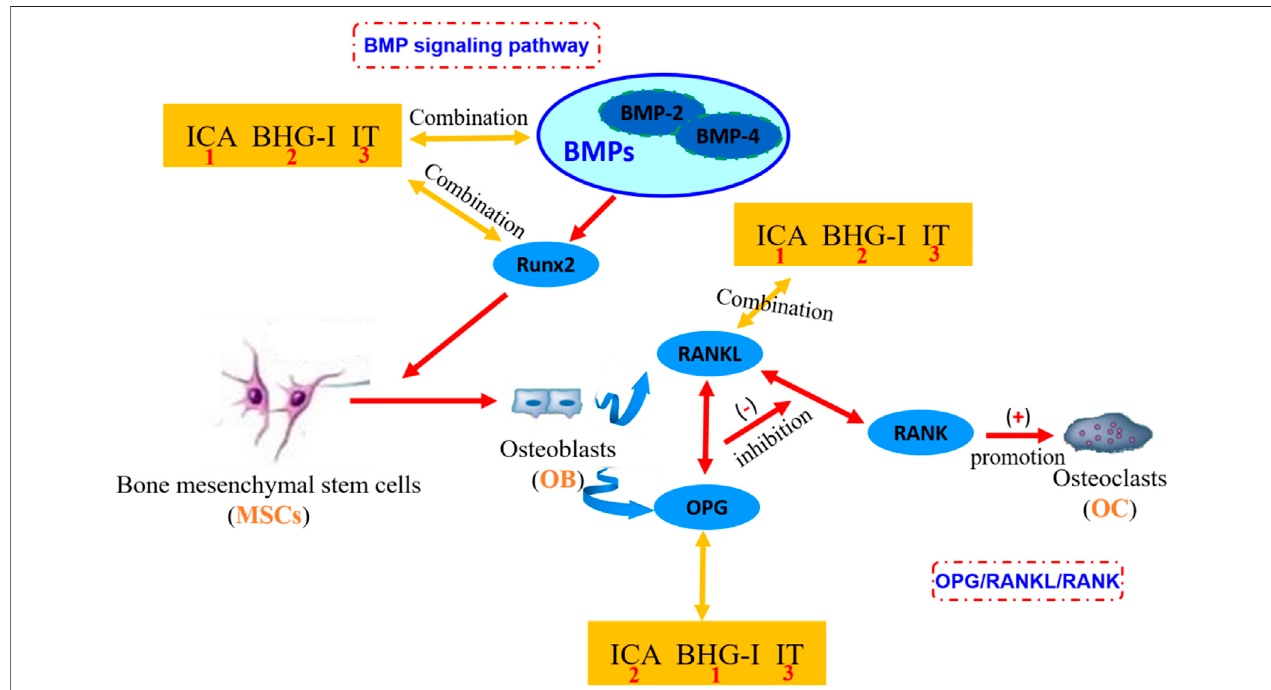
FIGURE6| Themechanismofaf fi nity/bioactivityofEF- fl avonoidsandbonemetabolismtargets.ICA,icariin;BHG-I,baohusideI;IT,icaritin.Inthe fi gure,theorange square frames are in the symbol of the small molecule ligands ICA, BHG-I, and IT. The blue boxes represent the protein targets in OPG/RANKL/RANK system or BMP signaling pathway. The numbers in the orange square frames represent the af fi nity of the compound with bone metabolic protein targets. The number 1 represents the combination between compound and target is more stable. These three compounds are equivalent to antagonists of bone metabolic targets. The more stable the binding, the less the effect of anti-GIBFI. This graph clearly shows the combination between receptors and protein targets. EF, Epimedii Folium; GIBFI, glucocorticoid- induced bone formation inhibition.